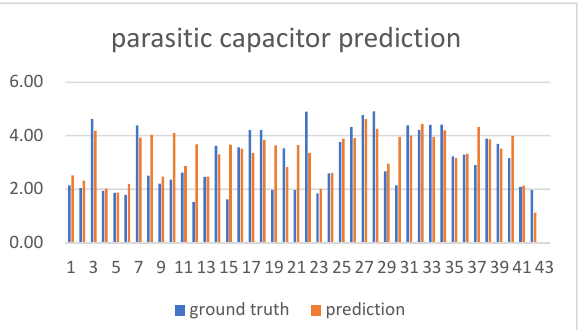
Figure 7. Capacitor prediction compared to tool-based RC extraction, the values are log-normalized to appear concise.